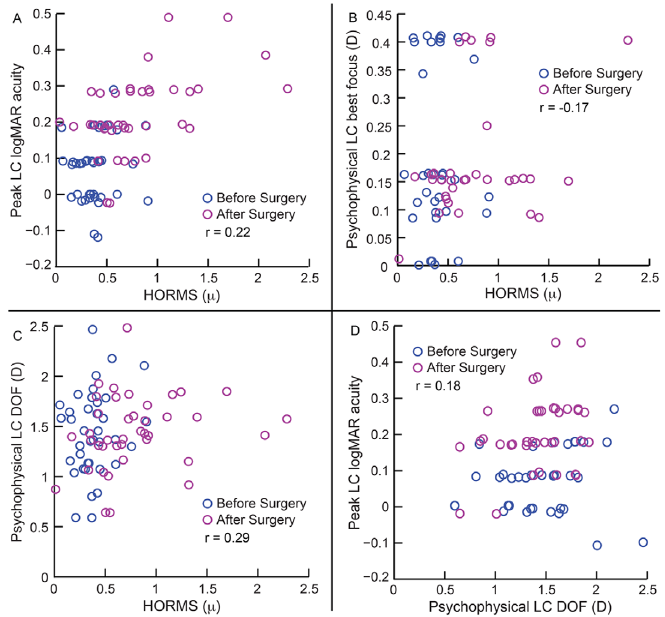
Fig 7. Relation between logMAR acuity, psychophysical best focus, psychophysical DOF and HORMS obtained from first control experiment. All other details are similar to Fig 5.